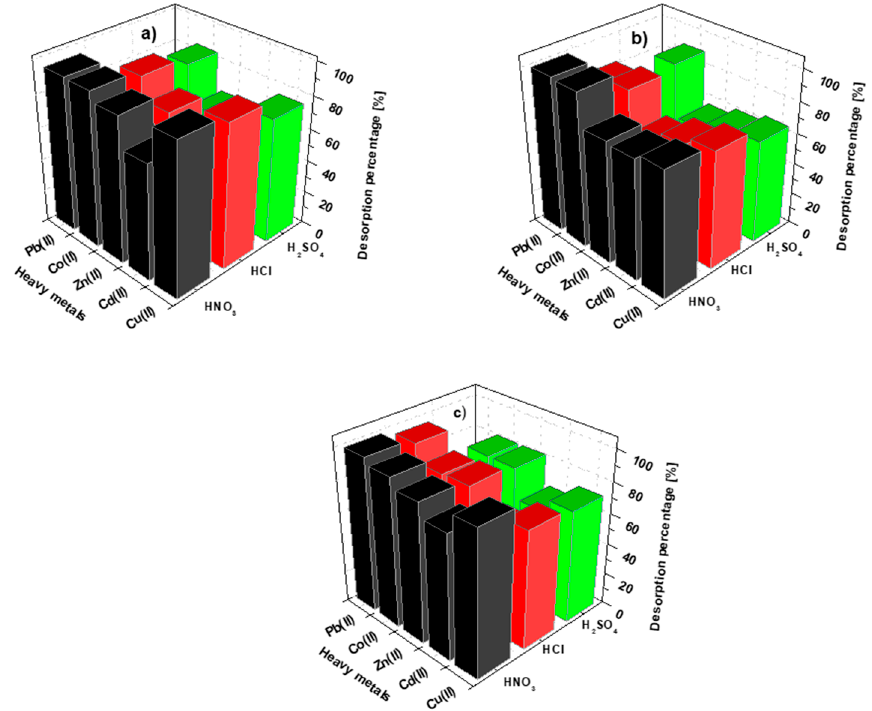
Figure 14 . Elution of Cu(II), Cd(II), Zn(II), Co(II) and Pb(II) from the metal-loaded ( a ) BC-CS 1-1, ( b ) BC-CS 2-1 and ( c ) BC-CS 4-1, using HNO 3 , HCl and H 2 SO 4 at a concentration 1 mol/L in three sorption–desorption cycles.